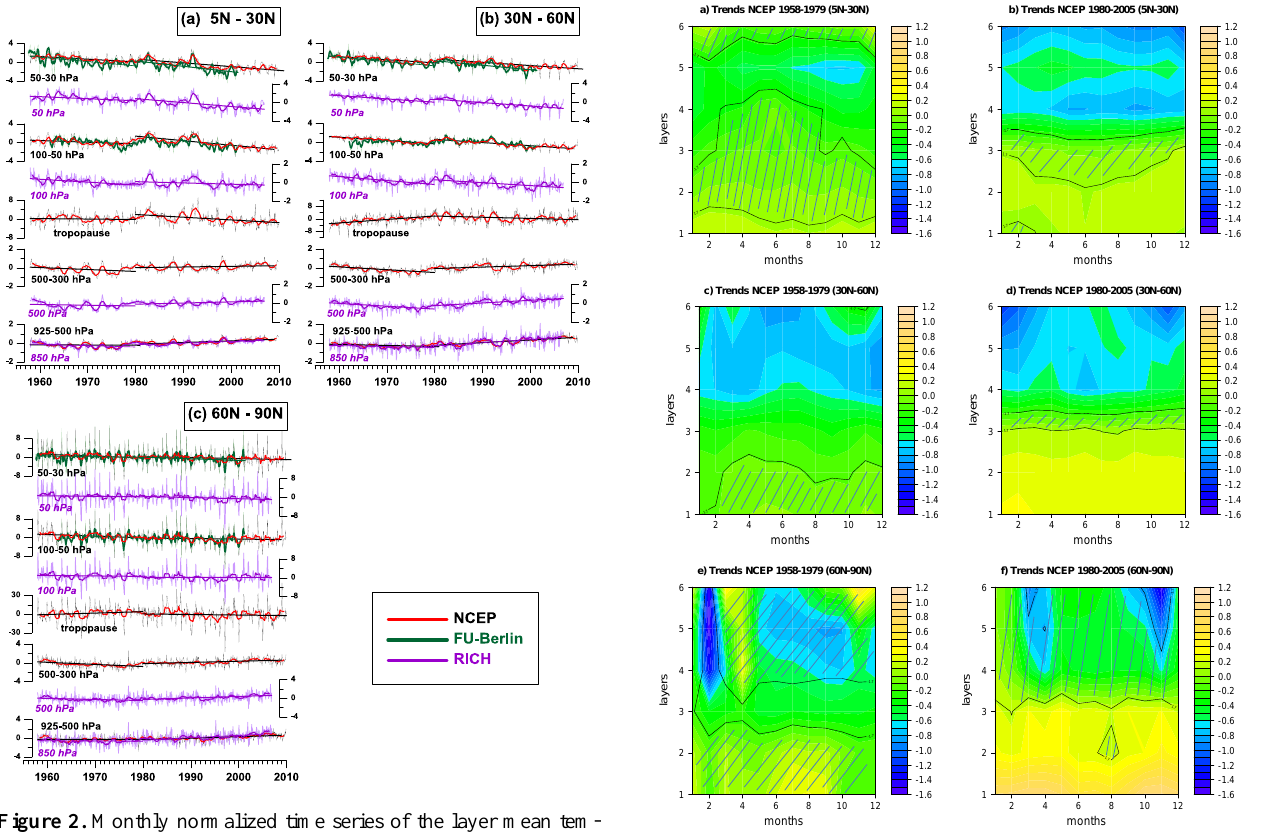
Figure 3 Figure 3. Layer mean temperature trends ( ◦ Cdecade − 1 ) for each month ( x axis) and layer ( y axis) based on NCEP reanalysis over the periods 1958–1979 and 1980–2005, respectively, for three lat- itudinal belts: (a) and (b) for 5–30 ◦ N, (c) and (d) for 30–60 ◦ N and (e) and (f) for 60–90 ◦ N. Layer 1: 1000–925hPa, Layer 2: 925–500hPa, Layer 3: 500–300hPa, Layer 4: 100–50hPa, Layer 5: 50–30hPa, and Layer 6: 30–10hPa. The shaded areas are non- statistically significant at the 90% confidence